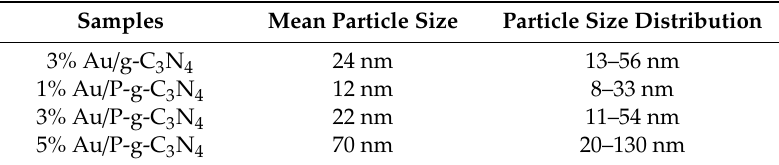
Table 2. Mean particle size and particle size distribution of all Au loaded samples.